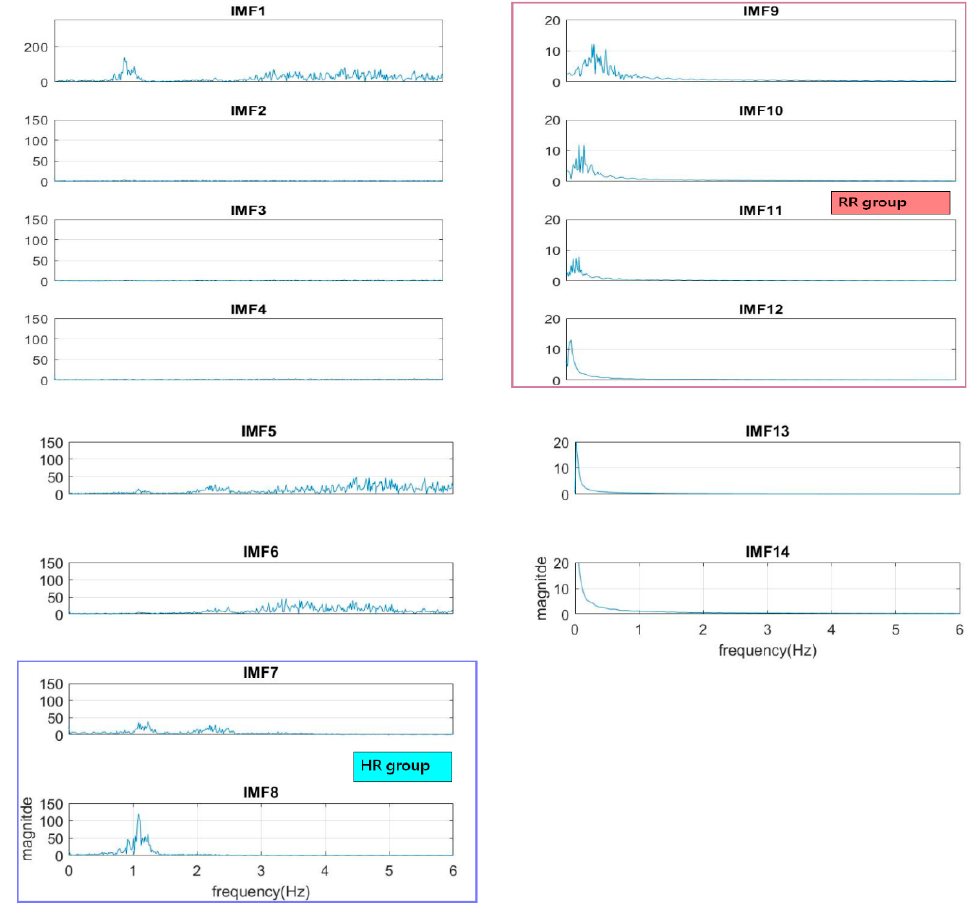
Figure 3. The spectra of IMFs (same one as in Figure 2).